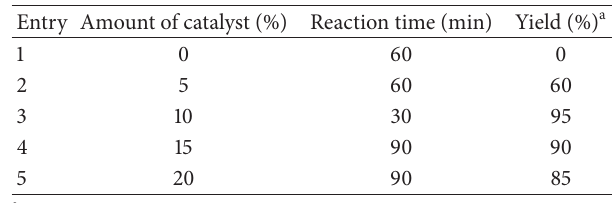
Table 1: Model reaction of o -phenylenediamine (1.0mmol) with benzaldehyde (1.05mmol) by using different amounts of catalyst boric acid in water at room temperature.